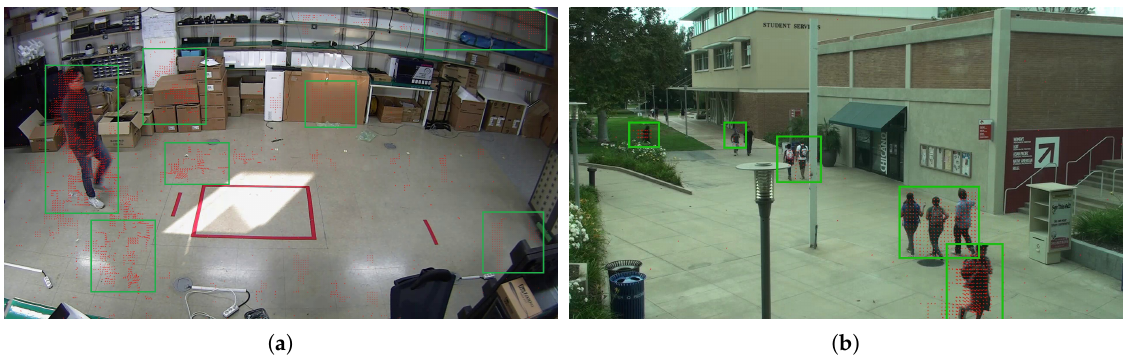
Figure 3. Example of motion vectors’ extraction. ( a ) Test video sequence from our recorded video. ( b ) Test video sequence from